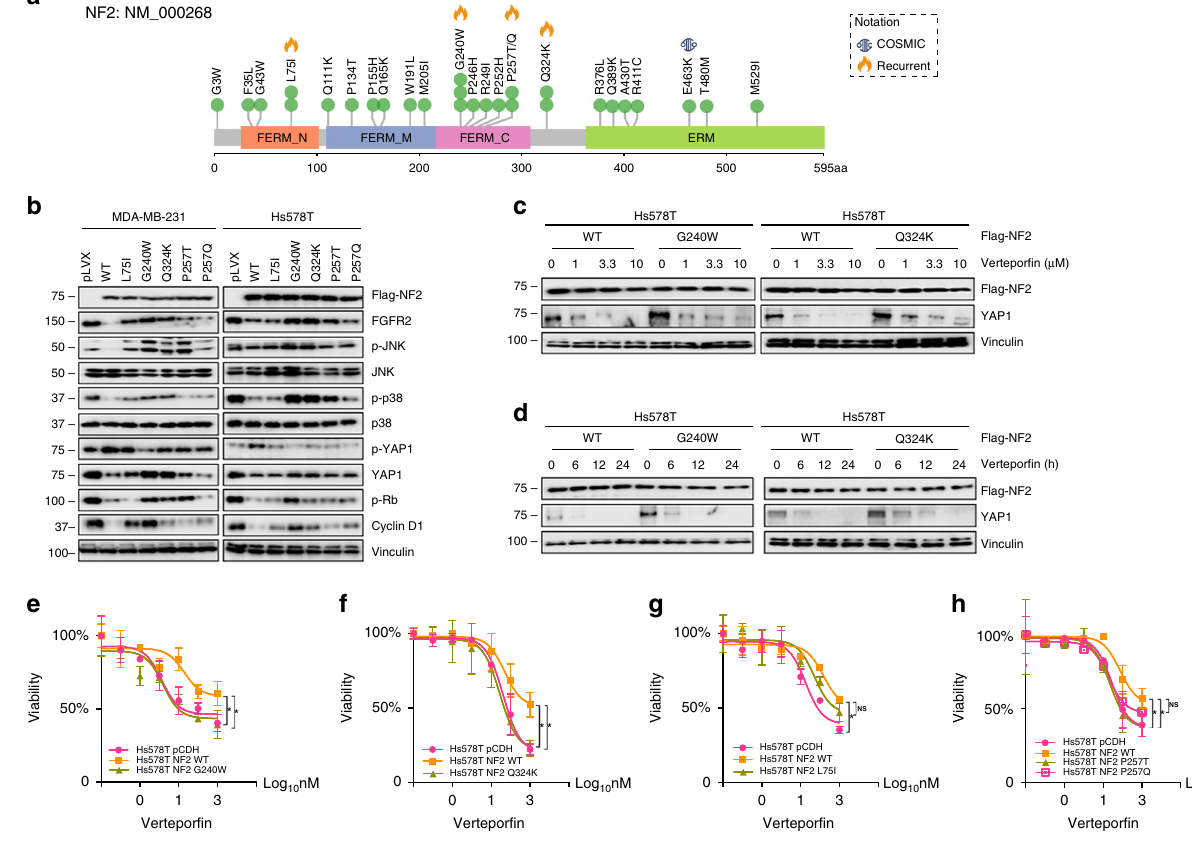
Fig. 6 NF2 mutations promote sensitivity to a YAP inhibitor. a NF2 missense mutations discovered in Chinese breast cancer samples. The mutations reported in the COSMIC dataset were annotated next to the residue site. NF2 L75I, G240W, P257T/Q, and Q324K were identi fi ed as recurrent spots in Chinese breast cancer. b Western blot showing the activation of Hippo and cell-cycle pathway effectors in NF2 -wild type and NF2 -mutated breast cancer cells. c Hs578T cells stably expressing Flag- NF2 -WT and Flag- NF2 -G240W/Q324K were treated with an increasing dose of Vertepor fi n. d Hs578T cells stably expressing Flag- NF2 -WT and Flag- NF2 -G240W/Q324K were treated with 1 μ M Vertepor fi n for 0, 6, 12, and 24 h. All western blots experiments are repeated three times. e – h Relative percentage of cell viability (%) of NF2 -WT and NF2 -mutated (G240W ( e ); Q324K ( f ); L75I ( g ); P257Q/T ( h )) Hs578T cells treated with Vertepor fi n. The half-maximal inhibitory concentration (IC 50 ) values were calculated based on the day 3 data of various doses of drug treatment. The assays were performed with fi ve replicates in three independent experiments; representative results are shown. These data represent the mean values, with error bars indicating the SEM (* P < 0.05). Source data for b – h are provided as a source data fi